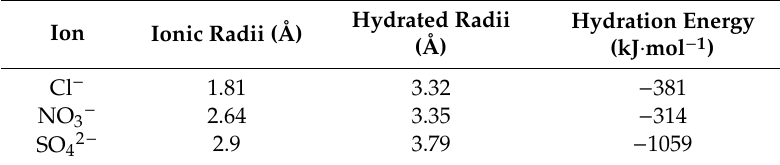
Table 4. Ionic radii, hydrated ionic radii and hydration energy of the studied anions [52,53].